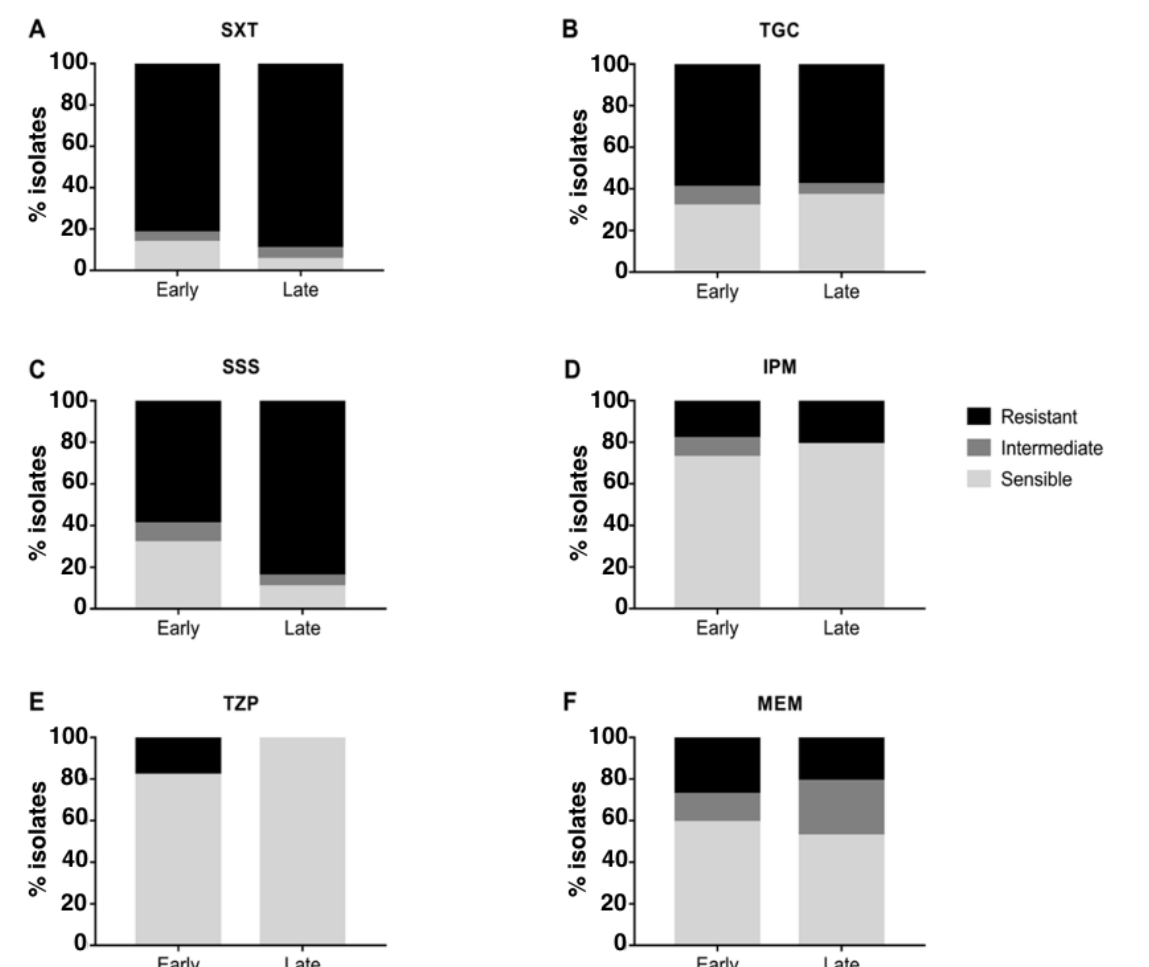
Figure 4. Antimicrobial susceptibility testing of early and late chronic isolates. The percentage of resistant, intermediate and sensible isolates from chronic and occasional infection are represented for each antibiotic tested. SXT = trimethoprim – sulfamethoxazole ( A ), TGC = tigecycline ( B ), SSS = sulfonamides ( C ), IPM = imipenem ( D ), TZP = piperacillin-tazobactam ( E ), MEM = meropenem ( F ).